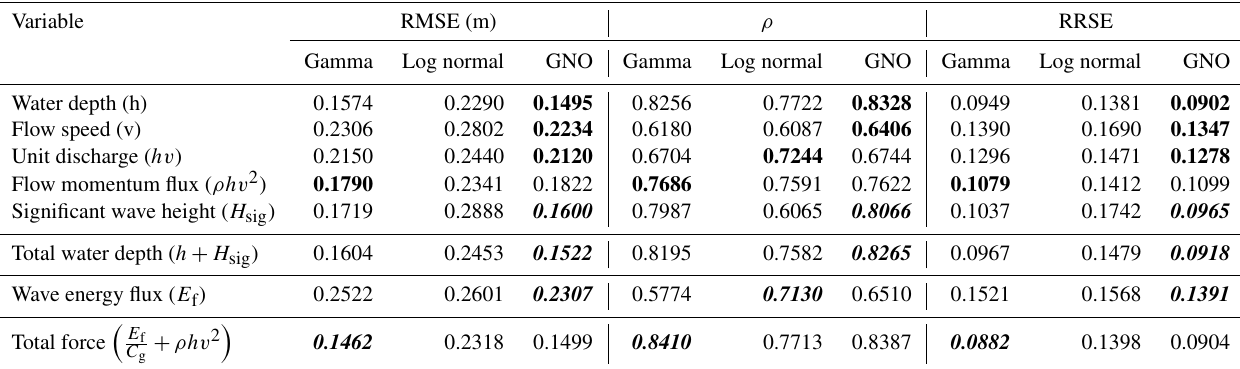
Table B1. Goodness-of-fit indices for the gamma, log-normal, and generalized normal statistical distributions. The best fits for flow-only parameters are indicated in bold, and the best fits for flow-plus-wave parameters are indicated in bold italic.